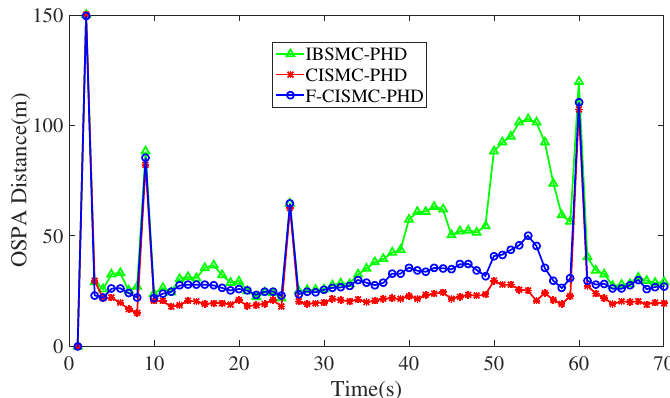
Figure 4. OSPA distances of the IBSMC-PHD, CISMC-PHD and F-CISMC-PHD approaches with clutter number being